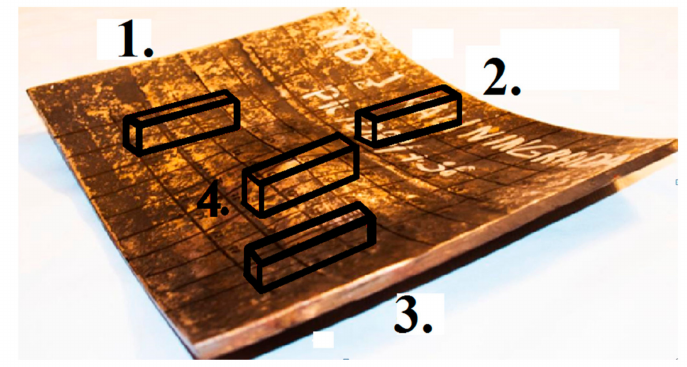
Figure 2. A schematic view of the preparation of Charpy V-notch test